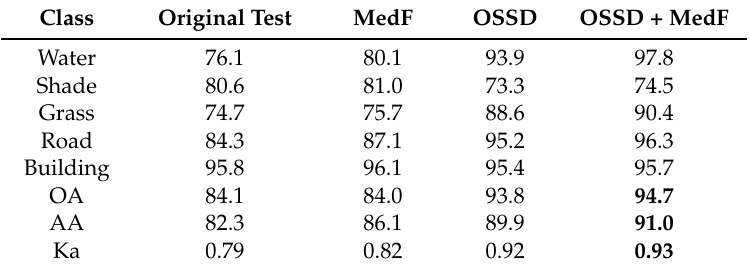
Table 3. Classification accuracies (aerial image) in percentage for the KNN classifier and the four tests.